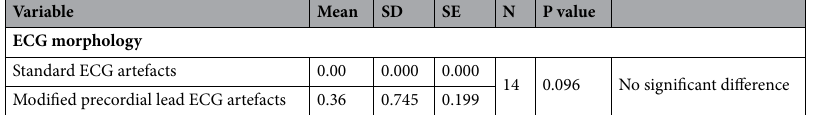
Table 3. Artefact differences between standard ECG and precordial lead ECG